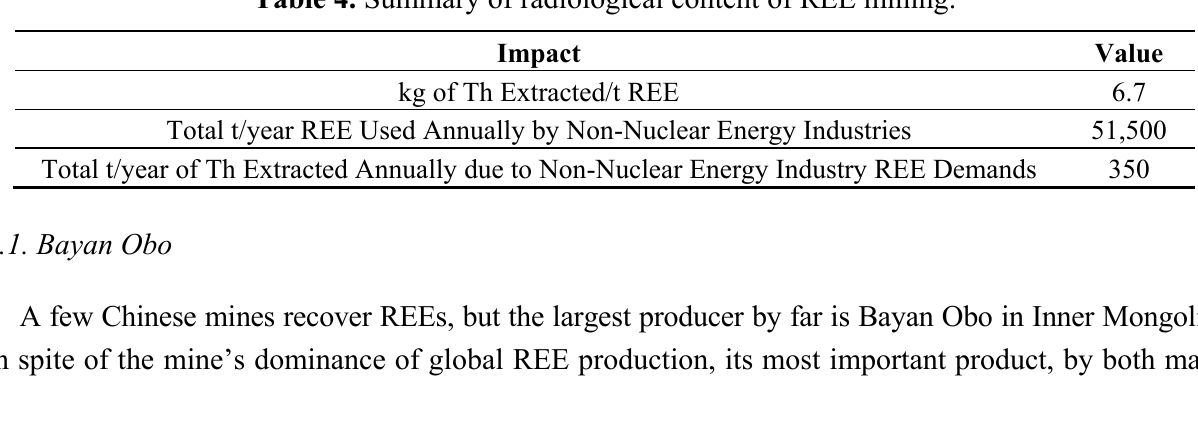
Table 4. Summary of radiological content of REE